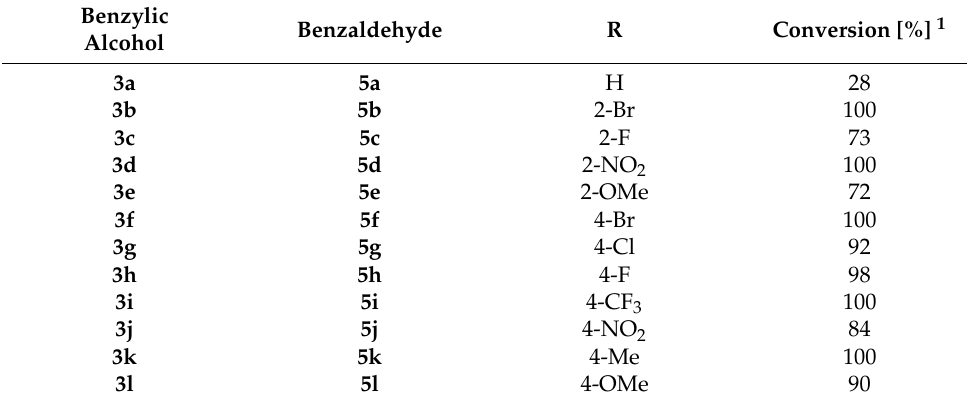
Table 1. Conversion of laccase-mediated oxidation.